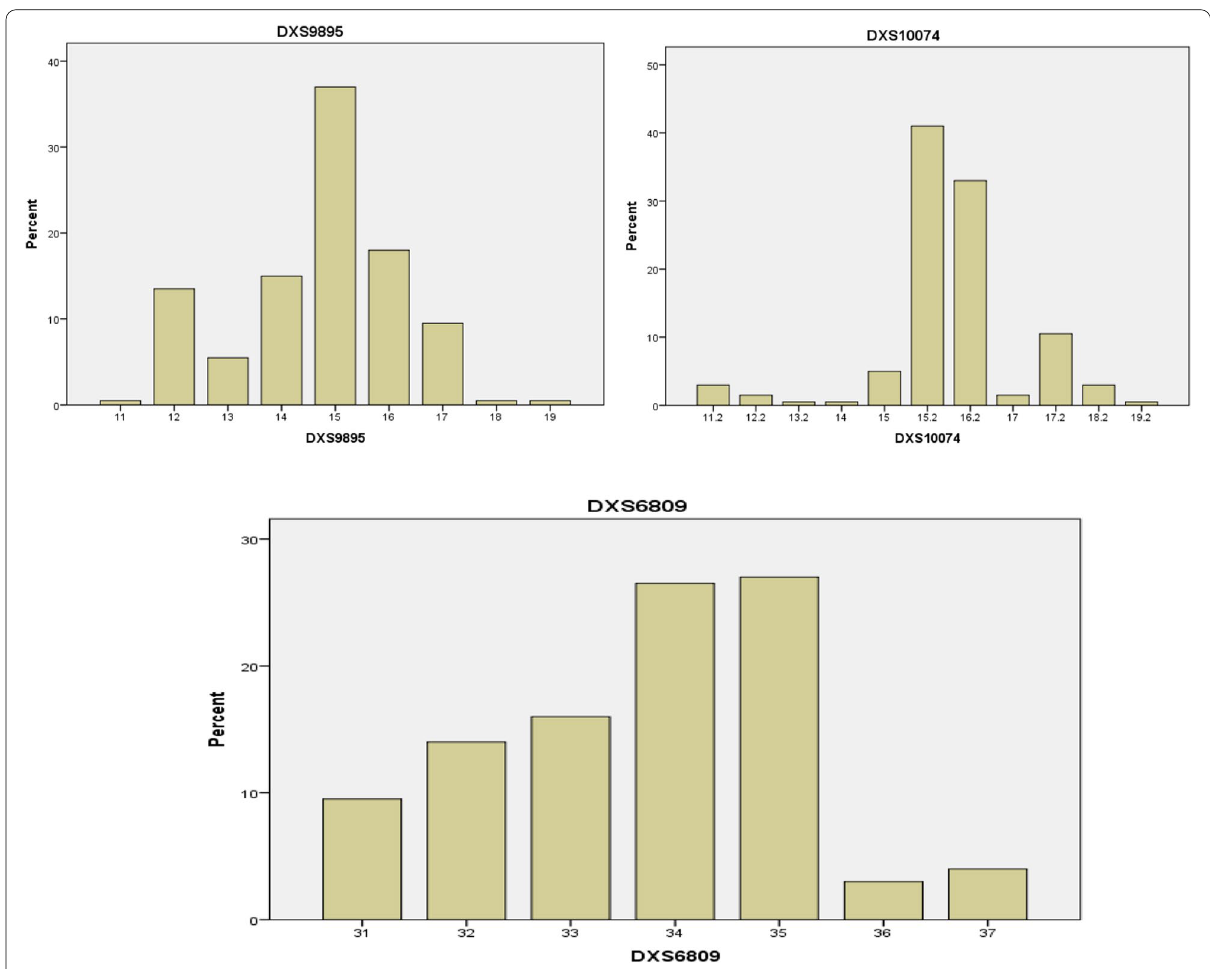
Fig. 4 The percent distribution of allele frequency of the third group (DXS9895, DXS10074, and DXS6809)